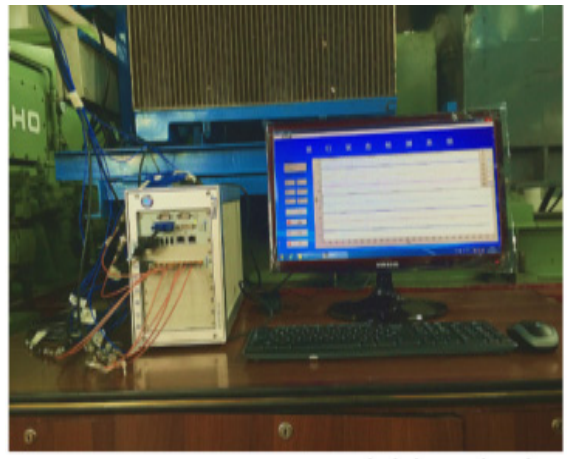
Figure 9. Data acquisition device .